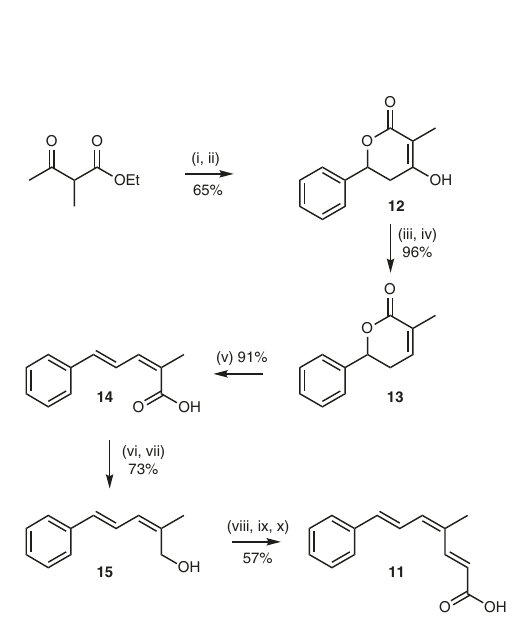
Fig. 4 Total synthesis of prestrobilurin A 11. Reagents and conditions: i PhCHO, n BuLi, i Pr 2 NH, HMPA, THF, − 78 °C; ii KOH (aq); iii Tf 2 O, i Pr 2 EtN,